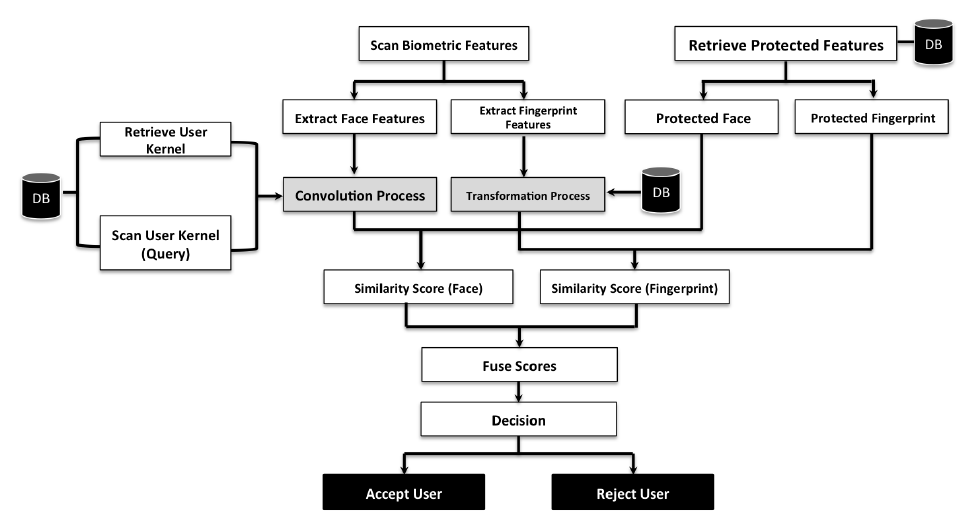
Figure 2. Proposed cancelable approach architecture (authentication